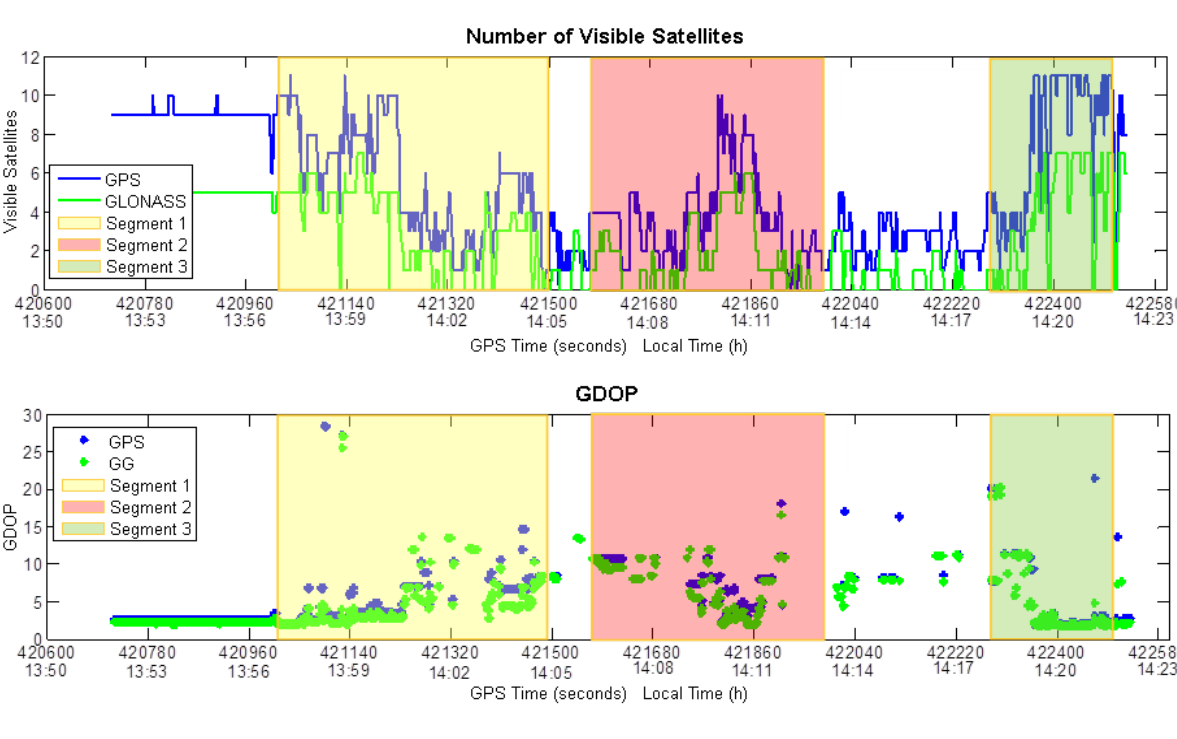
Figure 6. Visibility and GDOP during the test.